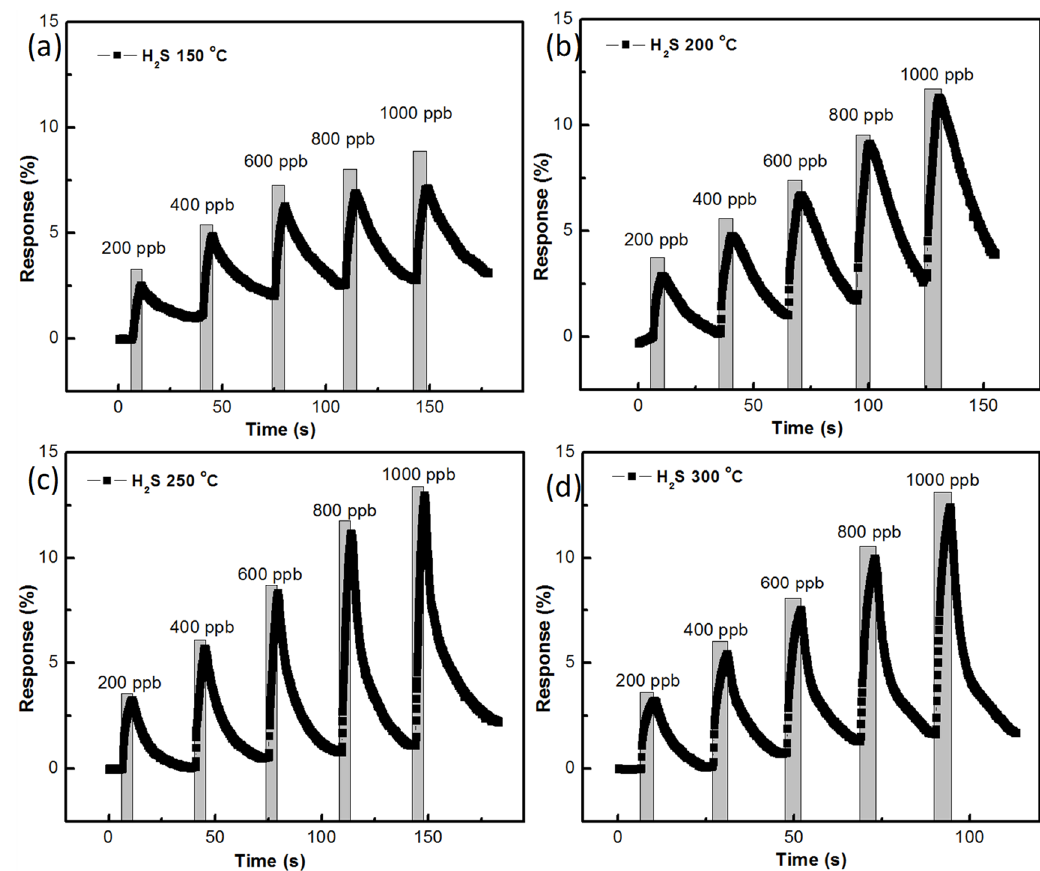
Figure 11. H 2 S gas-sensing response of the ZnO nanostructure prepared with 180 min growth time: ( a ) at 150 °C, ( b ) 200 °C, ( c ) 250 °C, ( d ) 300 °C.